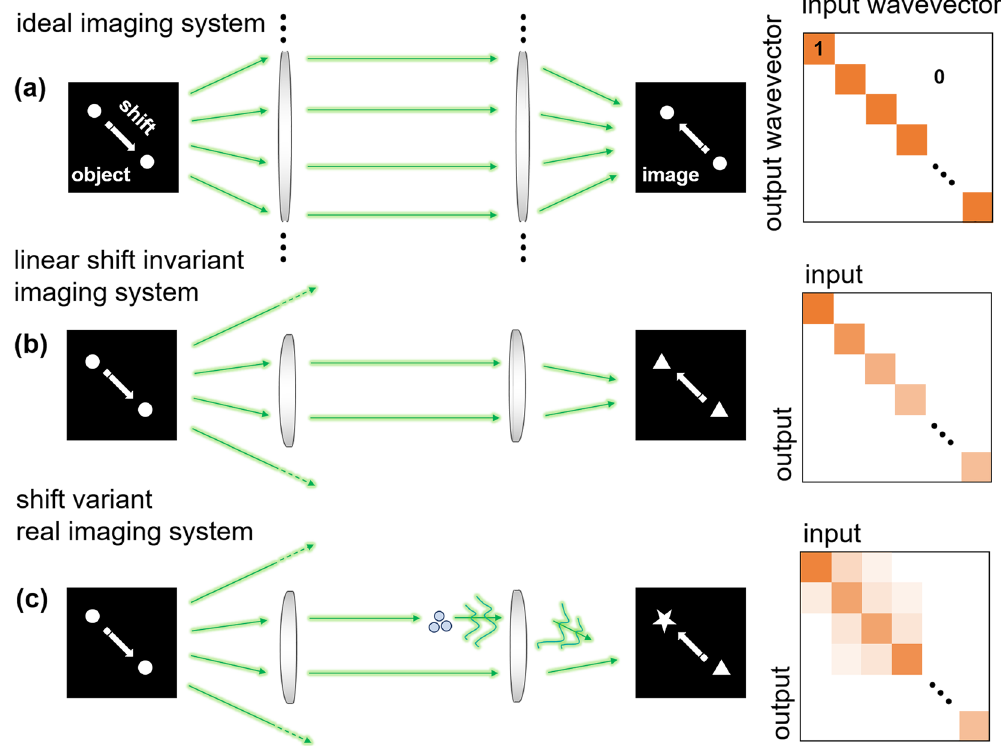
Figure 1. A schematic of the image forming capability of ( a ) ideal, ( b ) linear shift invariant, and ( c ) linear shift- variant imaging